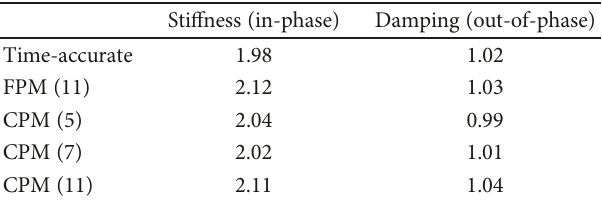
Table 5: Dynamic derivatives for ICE con fi guration from pitching moment. Sti ff ness (in-phase) Damping (out-of-phase)